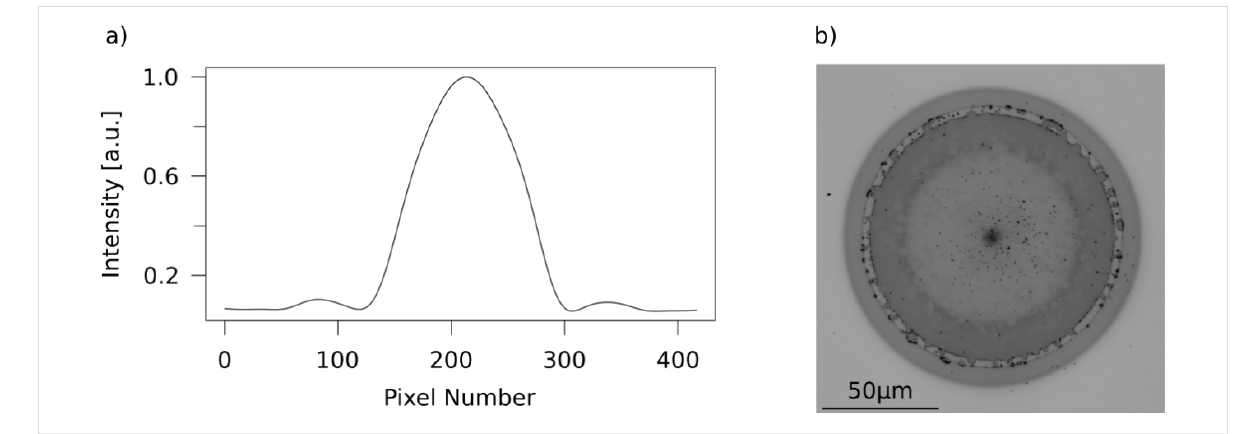
Figure 2: (a) Laser profile at the sample position taken with a CCD camera. Next to the central maximum the first Airy ring is clearly visible. (b) Optical microscope image of a Ge 2 Sb 2 Te 5 (GST) film, which was irradiated by a single laser pulse (15.5 μ J). In the central region the GST is completely ablated. The dark ring around this region shows were the local fluence was high enough to induce a phase change from the reflecting, crystalline to the amorphous, absorbing state of the GST.